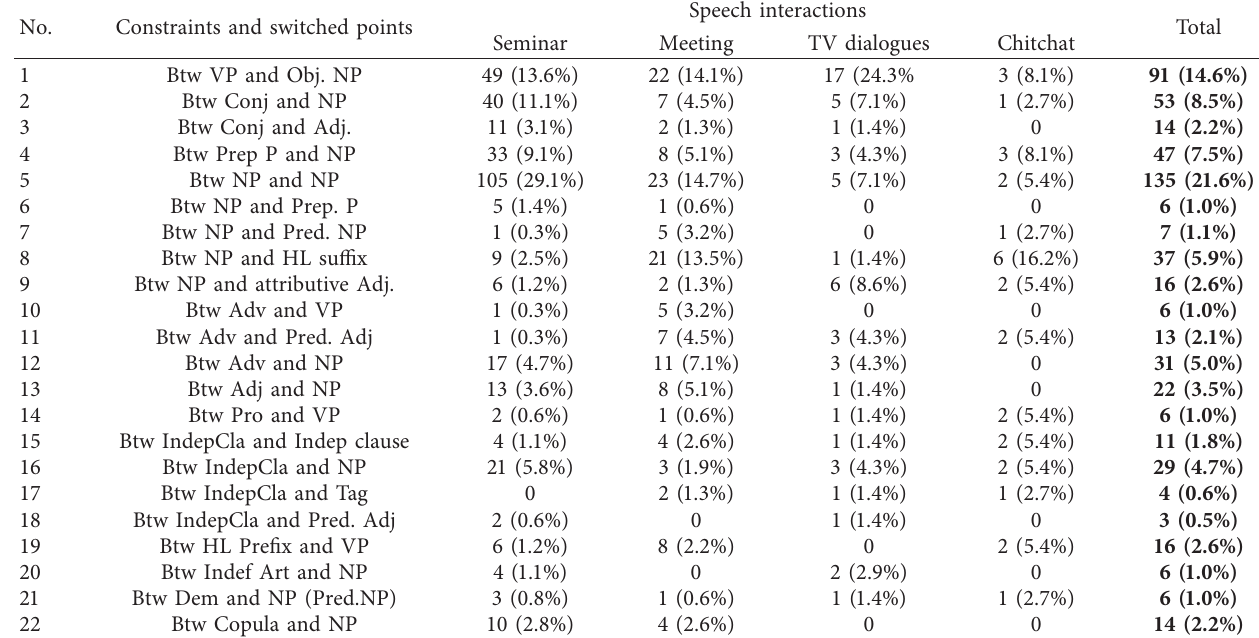
Table 3: The switched points of seminars, meetings, TV dialogues, and chitchats of Indonesian-English code-switching.